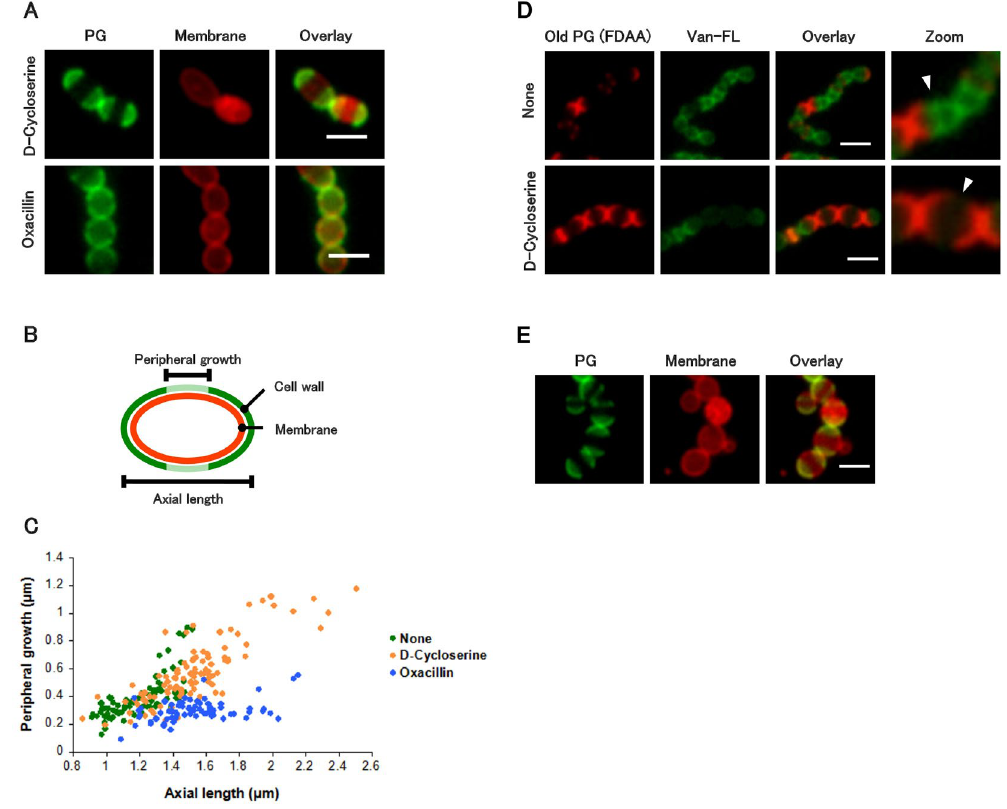
Figure 5. Excessive peripheral growth is the major cause of cell enlargement in d-cycloserine-treated cells, whereas peripheral growth has little contribution to cell size in oxacillin-treated cells. ( A ) Streptococcus pyogenes was pre-labeled with FDAA (1 h) and then allowed to grow without FDAA in the presence of d-cycloserine/ oxacillin (3 h). scale bar: 2 μ m. ( B ) Schematic presentation of peripheral and axial lengths in these experiments. The length of peripheral growth was estimated as the gap between old (stained) cell wall regions. ( C ) A dot blot analysis of the peripheral-growth/axial-length relationships of each cell suggested that peripheral growth barely contributed to cell enlargement in oxacillin-treated cells. Cells were treated with antibiotics for 3 h. Non-treated cells were analyzed 1 h after the FDAA pre-labeling because of their rapid growth. ( D ) Van-FL was used to stain cell walls with d-Ala-d-Ala terminus (30 min prior to analysis). The peripheral wall is expected to exist at a gap between old peptidoglycan regions. Van-FL staining did not localize at the newly synthesized peripheral cell wall (white arrow heads) in the presence of d-cycloserine. ( E ) Cell lysis in the presence of d-cycloserine at an excessive peripheral growth region; scale bar: 2 μ